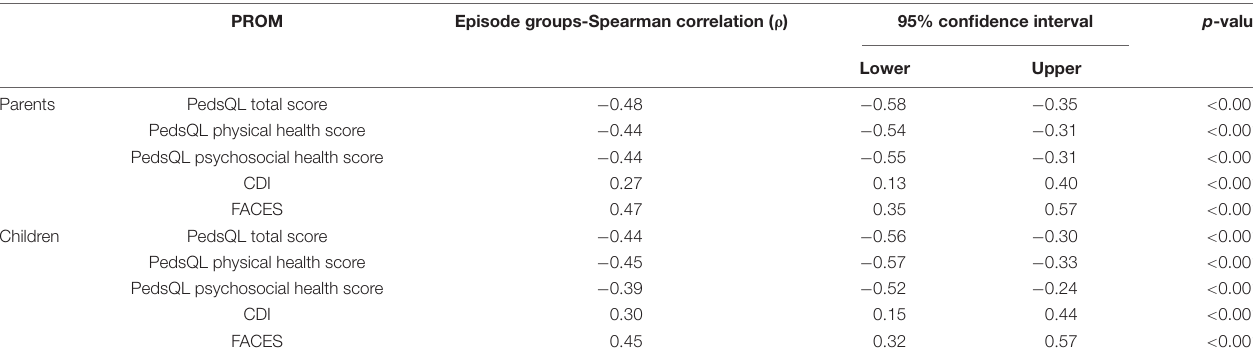
TABLE 4 | Results of Spearmen’s correlations between the number of episodes and